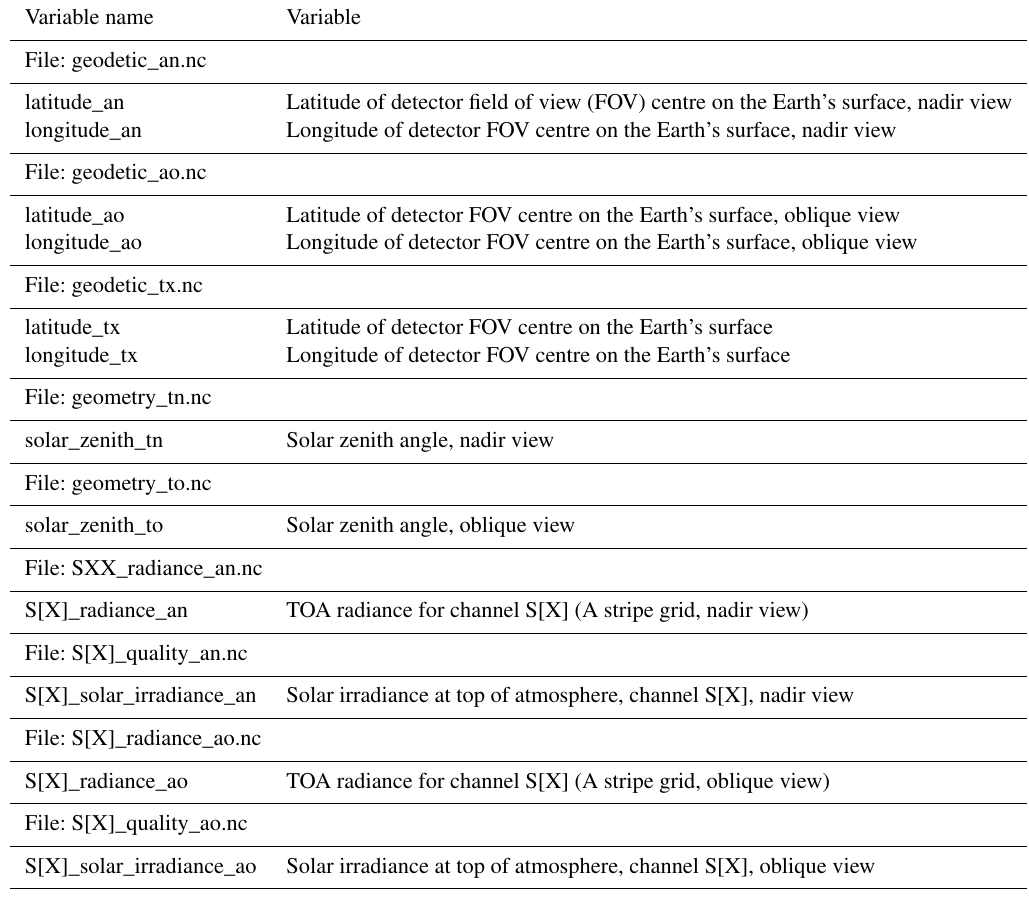
Table A1. Sentinel-3 SL_1_RBT files and variables used. Here, [X] denotes SLSTR band numbers 1–6. Variable name